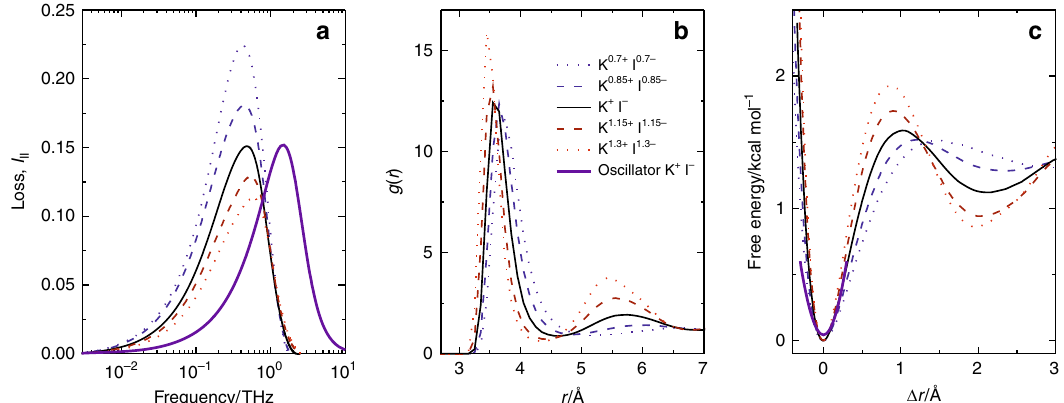
Fig. 2 Effect of the ionic distribution on the ionic dielectric response from charge-scaled MD simulations. a Ionic contribution I II to the dielectric loss as obtained from MD simulation of 0.5 mol L − 1 KI (solid black lines). To explore the effect of the ionic distribution, we also show the contribution based on the distributions obtained for KI with increased (1.15 and 1.30) and decreased (0.7 and 0.85) ionic charge (see legend in panel b ). Note that charge scaling was used to alter the distribution of ions. To isolate the effect of the distribution, we calculate I II assuming ions with unity charges. The purple curve in panel a shows the harmonic oscillator model for unity charged ions. b The altered ionic charge results in marked differences in the cation – anion RDF g ( r ): Increasing ionic charge results in sharper (more structured) peaks. c The cation – anion potential energy surface inferred from the RDFs. With decreasing charge density, the ions reside in shallower potentials. The purple line shows the harmonic approximation for the unity charged ions, which gives the purple spectrum shown in panel a